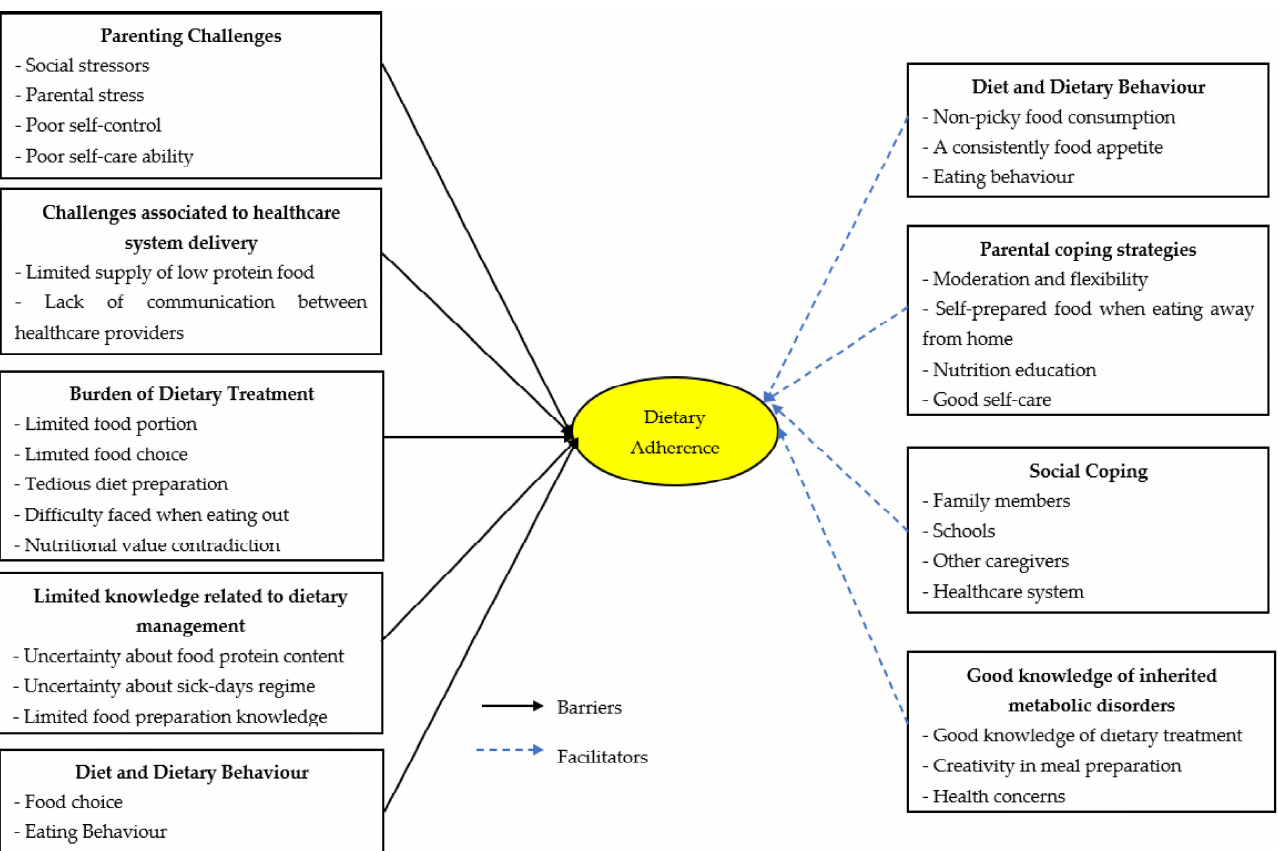
Figure 1. Barriers and facilitators to dietary adherence among AAMDs